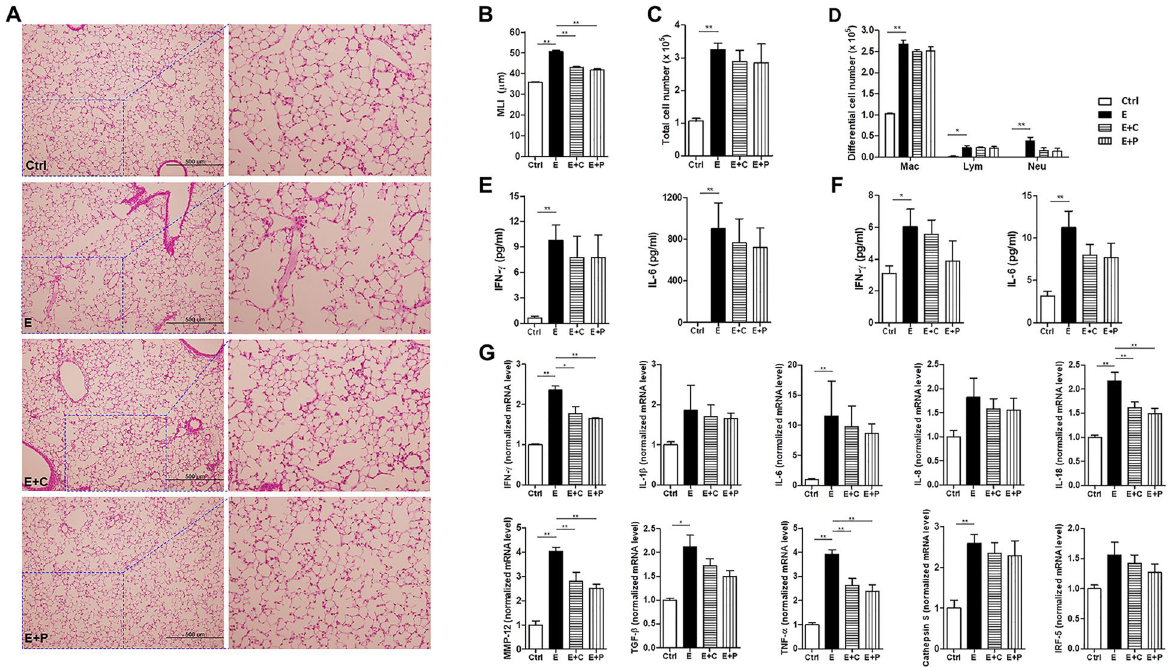
Figure 1. High-fiber diet attenuates inflammation and the degree of alveolar destruction. ( A ) Representative H&E-stained lung tissues from mice in the four groups (magnification: ×100 and ×400). ( B ) The mean linear intercept (MLI) of lung tissues from each group. ( C ) Total number of cells in the bronchoalveolar lavage fluid (BALF) infiltrating the airways. ( D ) Differential cell numbers of BALF in each group. ( E , F ) The levels of the cytokines IL-6 and IFN-γ in the BALF ( E ) and serum ( F ) were measured using ELISA. ( G ) The relative mRNA levels of IFN-γ, IL-1β, IL-6, IL-8, IL-18, IRF-5, MMP-12, TNF-α, TGF-β, and cathepsin S in lung tissues. (n = 5–6 mice per group). Values are expressed as the mean ± SE. * P < 0.05 and ** P < 0.01. Ctrl control group, E emphysema group, E + C emphysema with high-cellulose diet group, E + P emphysema with high-pectin diet group.